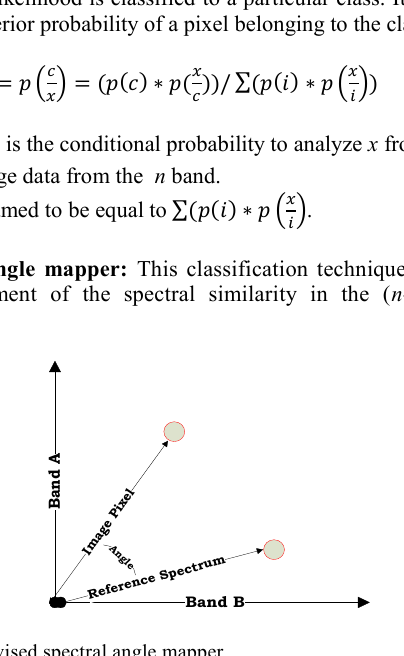
Fig. 3 Supervised spectral angle